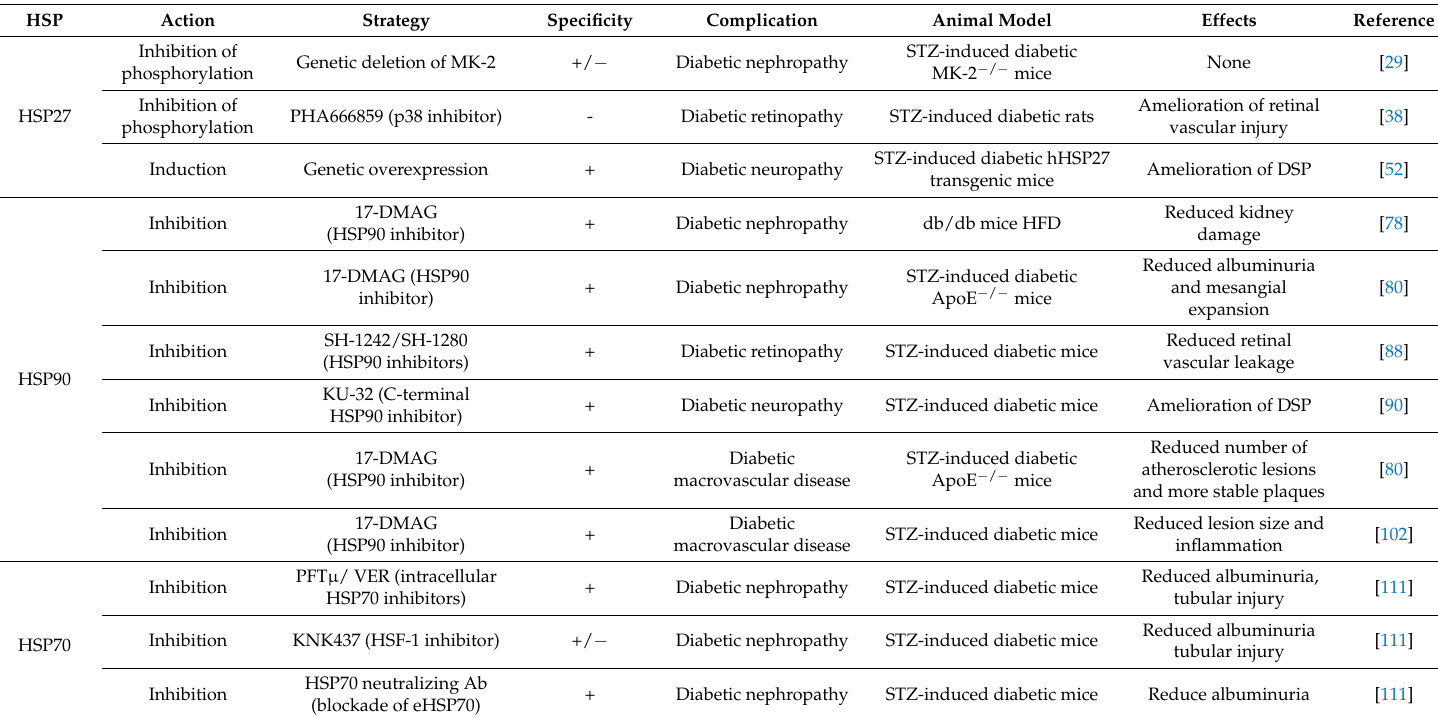
MK-2: MAP kinase-activated protein kinase 2; STZ: streptozotocin; DSP: distal symmetric polyneuropathy; 17-DMAG: 17-dimethylaminoethylamino-17-demethoxygeldanamycin; eHSP70: extracellular HSP70. HSP27 = HSPB1; HSP90 = HSPC; HSP70 =